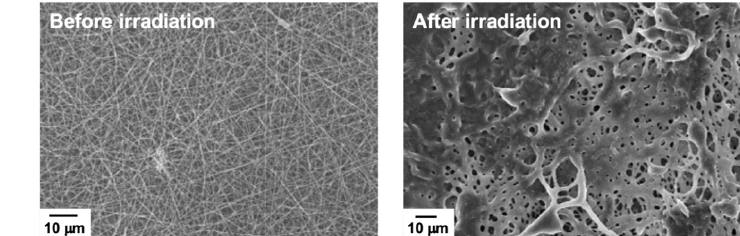
Figure 4. ( a ) Temperature profiles of P2 , P2ID nanofibers and free ICG as a function of irradiation time under continuous NIR laser irradiation (a power density of 0.78 W/cm 2 ). ( b ) Temperature change of P2ID nanofibers over five on/off cycles of repeated NIR laser irradiation (a power density of 0.78 W/cm 2 ). ( c ) FE-SEM images of P2ID nanofibers before and after NIR irradiation at a power density of 0.78 W/cm 2 for 10 min.